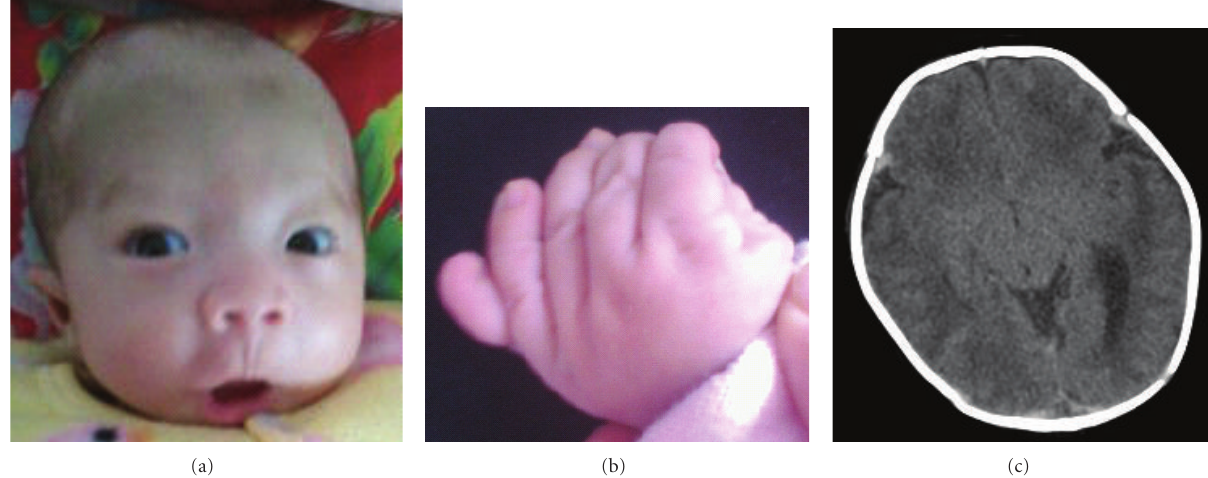
Figure 1: Photographs of patient at one-month old. (a) Facial features of frontal bossing, low and flat nasal bridge, low-set ears, nasal bridge hypoplasia, hypertelorism, and bilateral epicanthus. (b) Polydactyly of her left hand. (c) CT scan of subarachnoid hemorrhage.